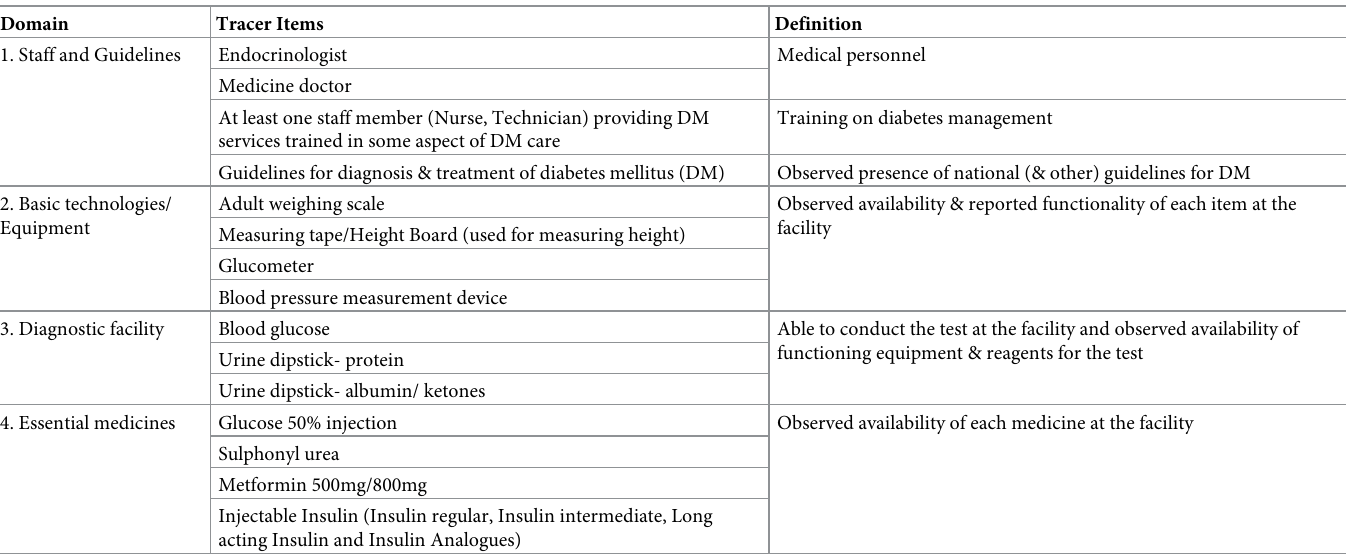
Table 1. Tracer items in respective domains for diabetes mellitus